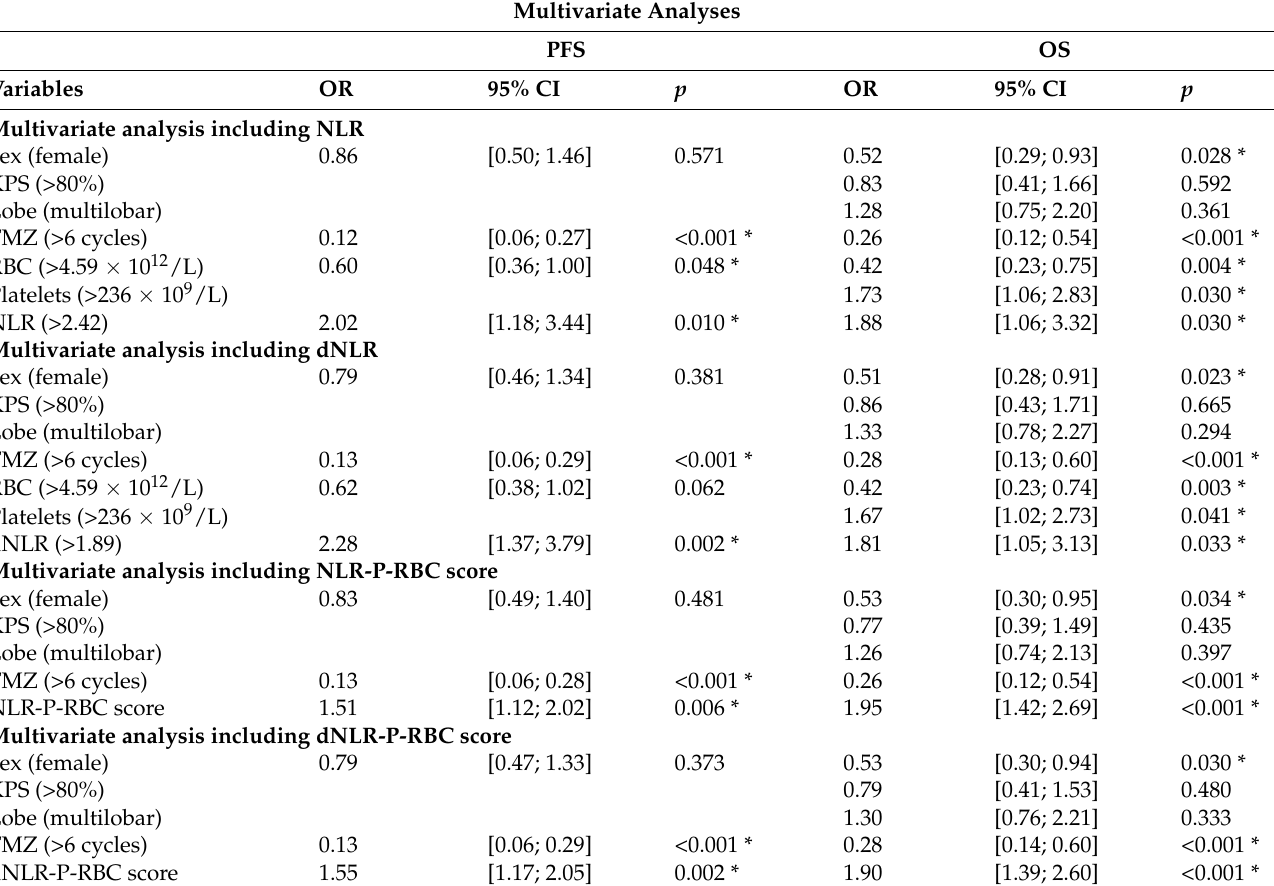
Table 3. Multivariate Cox regression analyses of factors associated with PFS and OS. Abbreviations: CI, confidence interval; dNLR, derived neutrophil-to-lymphocyte ratio; dNLR-P-RBC, dNLR-platelet count-red blood cell count; KPS, Karnofsky performance score; NLR, neutrophil-to-lymphocyte ratio; NLR-P-RBC, NLR-platelet count-red blood cell count; OR, odds ratio; PFS, progression-free survival; RBC, red blood cells; TMZ, temozolomide. * p < 0.05. Multivariate Analyses